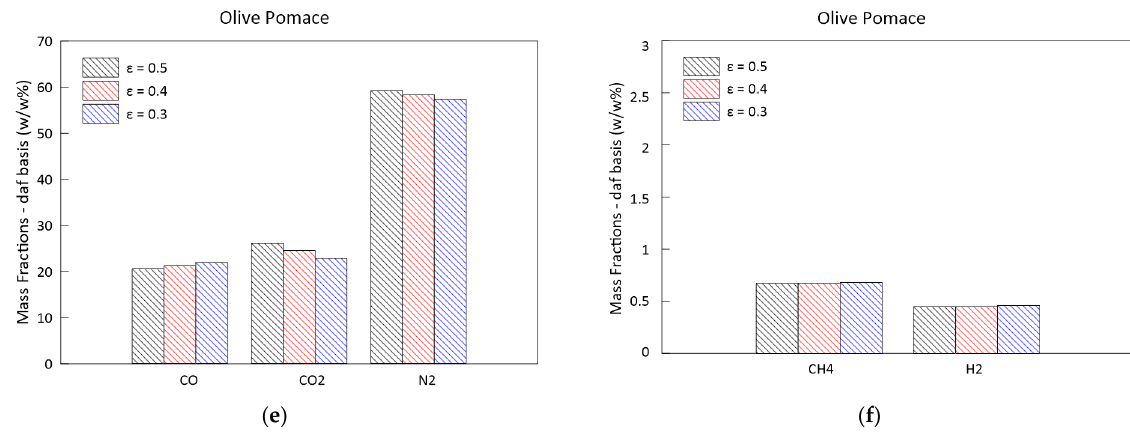
Figure 15. Species mass fractions (on a daf basis) at the reactor exit section, at different ε , for ( a , b ) woodchip case 1, ( c , d ) hydro-char from green waste, ( e , f ) olive pomace gasification.